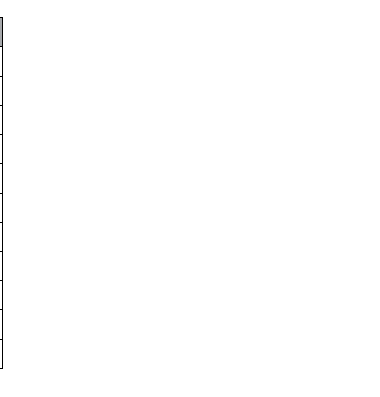
Table 1. DSC parameters of PHBV and PHBV/ENR blends.